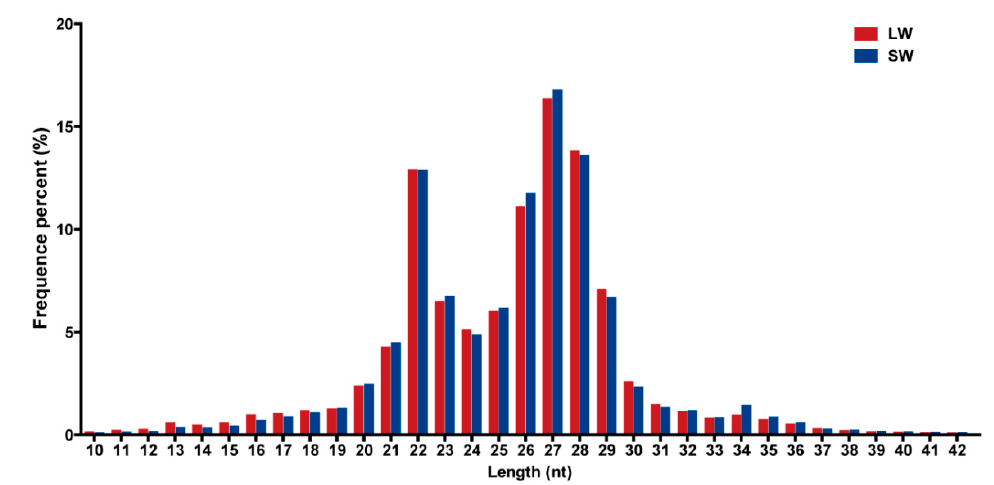
Figure 1. Distribution of total small RNA read lengths in long-wing (LW) and short-wing (SW) brown planthopper (BPH) strains.